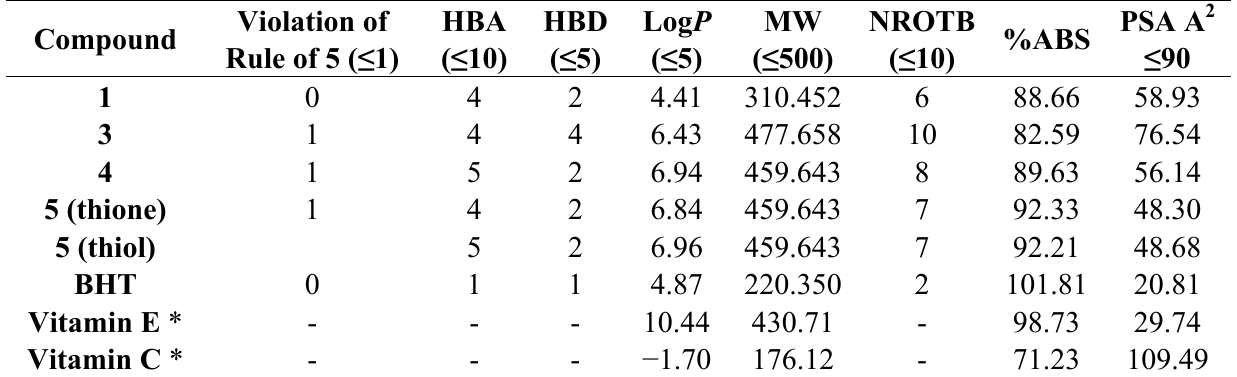
Table 5. Predicted ADMET and Lipinski’s